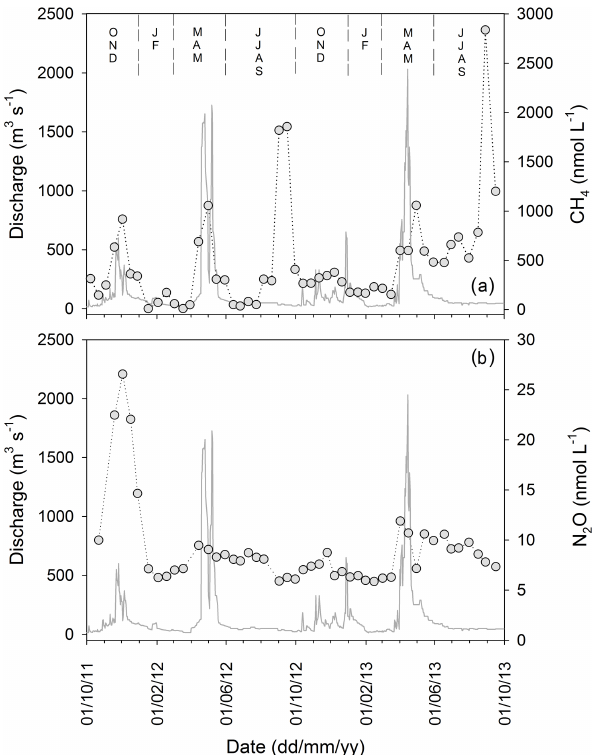
Figure 7. Two years of monitoring concentrations of dissolved (a) methane and (b) nitrous oxide. Grey circles represent riverine gas